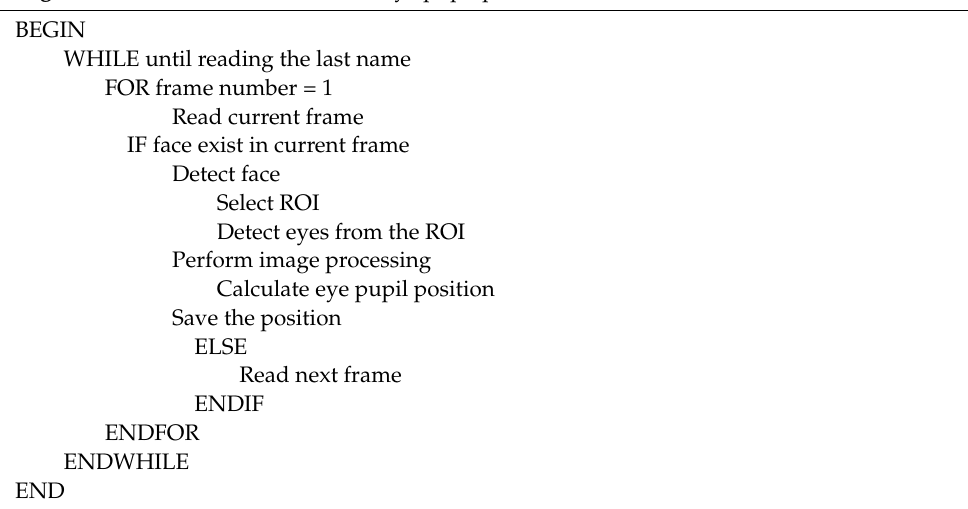
Algorithm 1. Pseudocode for extract eye pupil positions